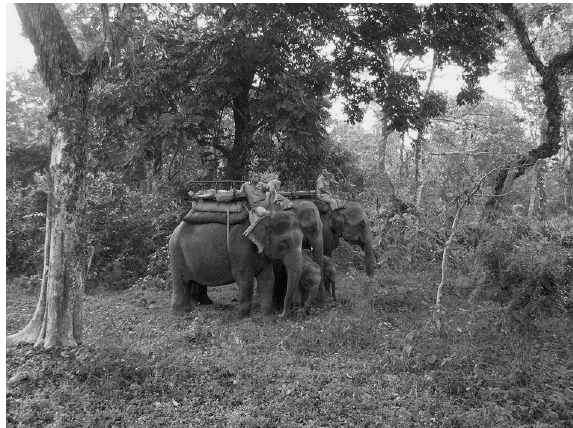
Fig. 2a. Prepared elephants to the tourist safari in Jald- hapara Wildlife Sanctuary between Torsa and Gabur-Basra rivers. The natural forest in the background.